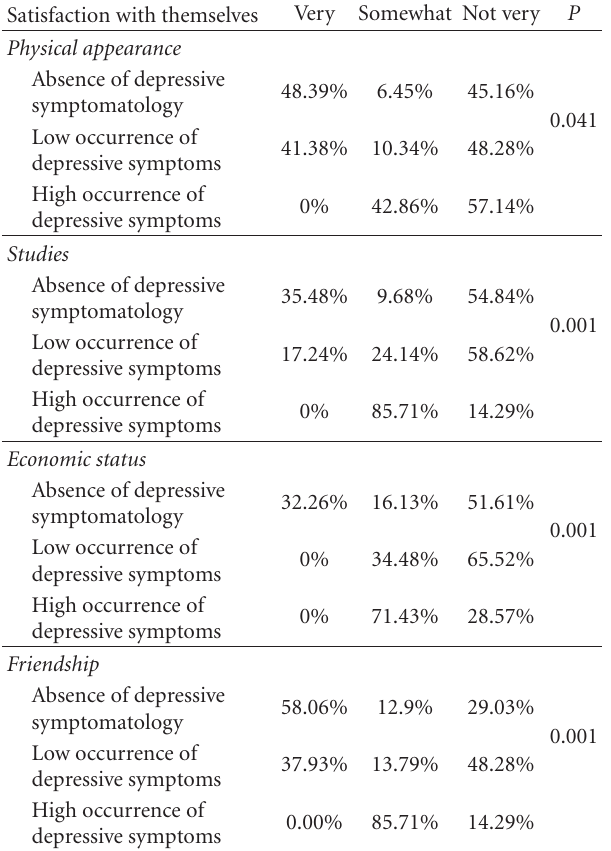
Table 4: Correlation of depressive symptoms with satisfaction with their physical appearance, studies, economic status, and